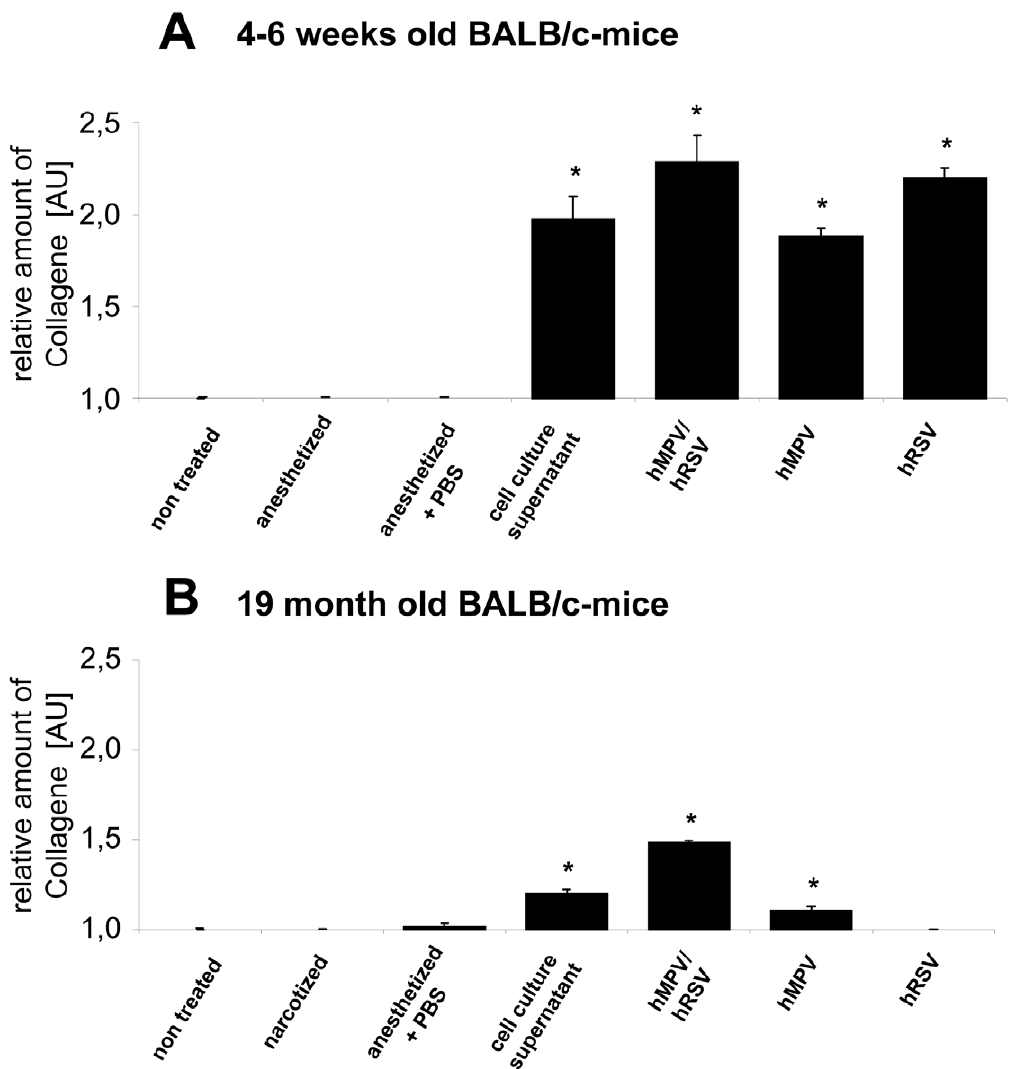
Figure 6. Soluble Collagen Expression in the infected lung. Amount of soluble collagens in the lungs of 4–6 weeks (A) und 19 months (B) old BALB/c mice after infection with RSV, HMPV or double infection: 4–6 weeks and 19 months old BALB/c mice were infected with 2 6 10 7 geq RSV, or HMPV, or co-infected with 1 6 10 7 geq of each virus. Untreated animals, animals anesthetized and treated with cell culture supernatant or PBS or only anesthetized served as controls. Mice were killed by cervical dislocation and the lungs were removed and homogenised. The amount of soluble collagens was determined by a collagen assay. Values were standardized referring to non treated controls (n=3–5, values are shown as mean 6 standard deviation). * significantly different to untreated animals (p , 0.05).